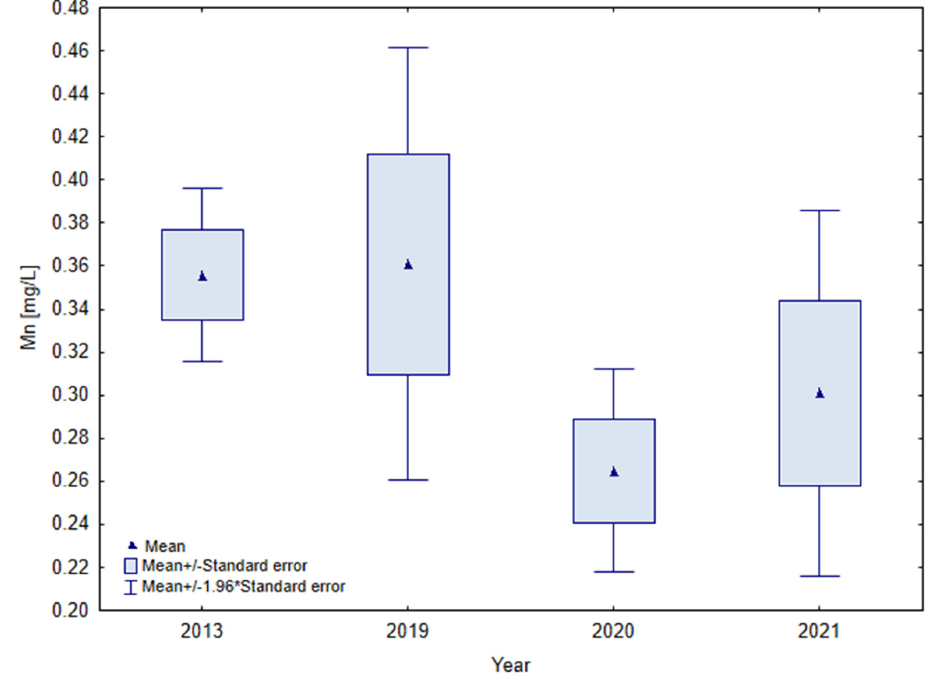
Figure 7. Average annual values of Mn content in the water of Lake Mielenko.